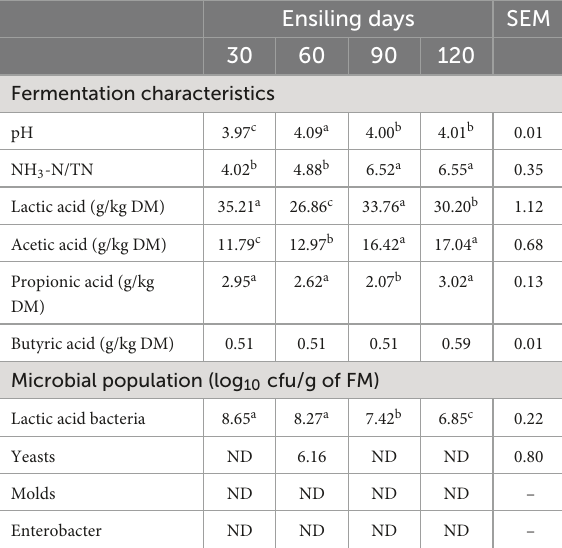
TABLE 2 Fermentation characteristics and microbial population after ensiling.